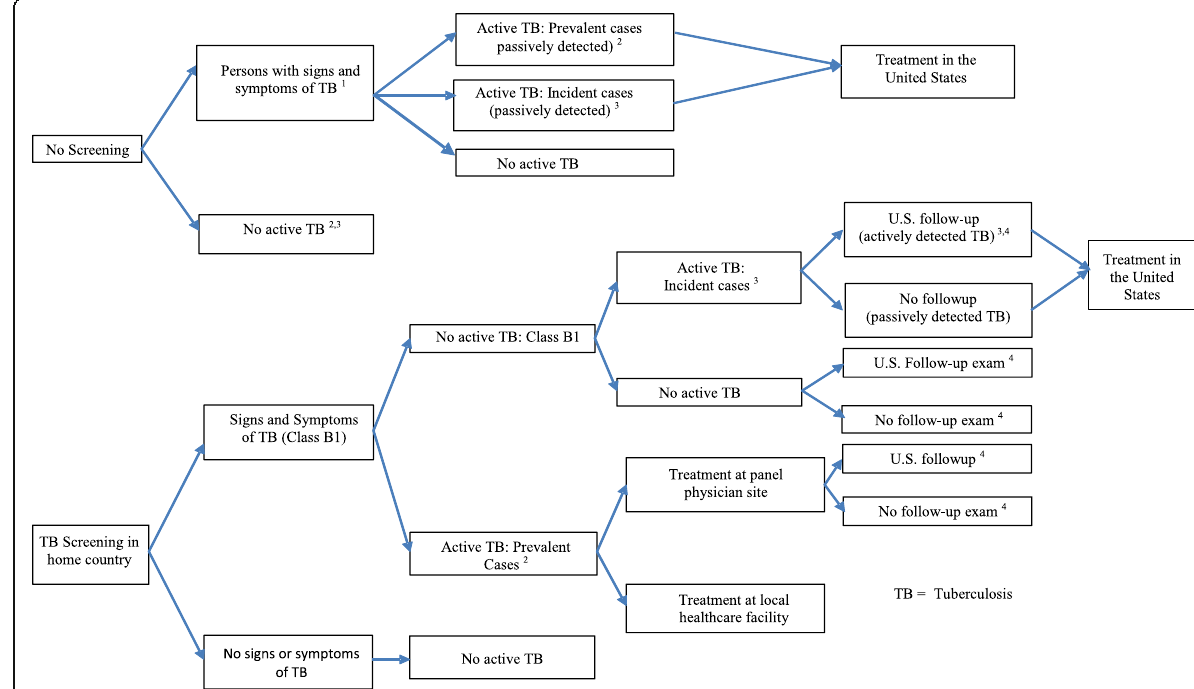
Fig. 1 Decision Tree Model Comparing a Screening Program for Nonimmigrant Visa Applicants to No Screening Notes: Decision model does not display all nodes. Each cohort proceeds through the screening and no-screening arms of the model. PHD: public health department, TB: tuberculosis, NIV- non-immigrant visa. For the no-screening arm, all cases are diagnosed passively and treated in the United States. All costs accrue in the United States. For the screening arm, costs accrue in applicants ’ home countries and in the United States. Costs are incurred for the panel physician medical exams and diagnosis and treatment as necessary. 1 The probability that an applicant has signs and symptoms of TB is based on the country-specific immigrant rate multiplied by a country-specific correction factor for applying immigrant data to our hypothetical populations. 2 The number of active TB cases among NIV candidates from India and Mexico is the cohort size multiplied by the fraction with clinical findings suggestive of TB and by the fraction diagnosed with active TB given signs and symptoms. This group of applicants with active TB will not be able to enter the United States until they complete treatment. Among these, the probability that they are treated by panel physicians is applied to determine cost of treatment to the patient via panel physician (opportunity and treatment costs) and to the national government (treatment costs for those treated outside the panel physician). Recruitment and visa costs are incurred by U.S.-based H-1B employers when applicants are treated outside the panel physician site. 3 The total number of active TB cases in each cohort is the sum of the prevalent cases and incident cases. 4 Among those with clinical signs or symptoms suggestive of TB, 78.6% of Mexicans and Indians follow up with PHDs after arrival in the United States. Among Class B1 arrivals who did not have active TB, 2.6% of Indians and 0.6% of Mexicans develop incident cases of TB and incur treatment costs in the United States. Such cases will be detected actively if they follow up with a PHD or passively if they do